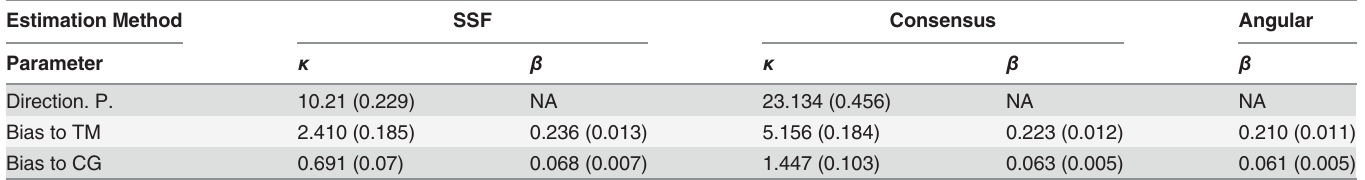
Three sets of estimates, using the step selection function (SSF) conditional logistic regression, the consensus and the angular circular regression models are provided, together with robust standard errors in